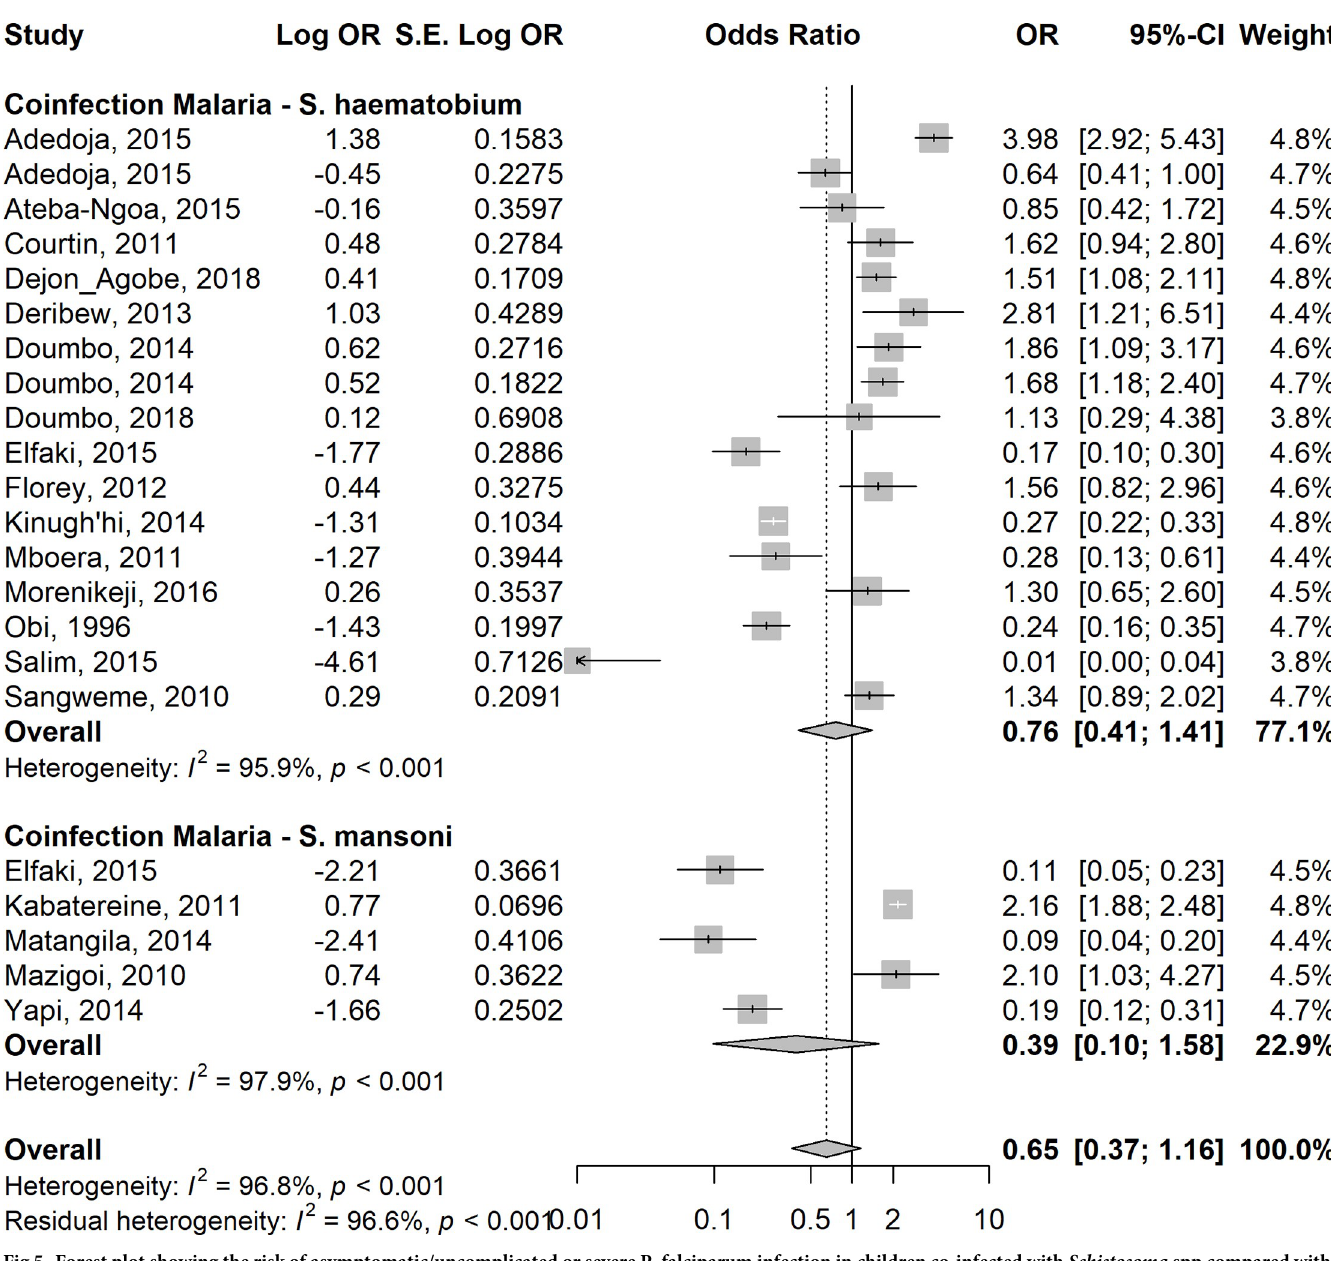
Plasmodium -helminth co-infections. The prevalence of hookworm- Plasmodium co-infection was significantly higher in boys than girls, but no gender difference was observed in the preva- lence of A . lumbricoides-Plasmodium co-infection [42, 43]. Children had 9.3 times the odds of co-infection compared to adults (95%CI = 5.3–16.3), with children aged 7–9 years most fre- quently co-infected with S . haematobium followed by the age group 4–6 years [58]. This find- ing is in agreement with that of another study [52] but conflicts with other findings [85].